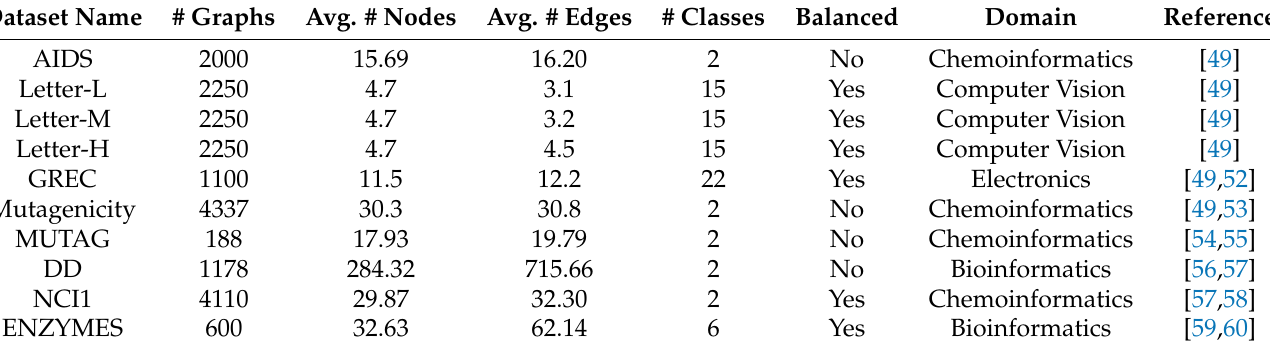
Table 1. Dataset